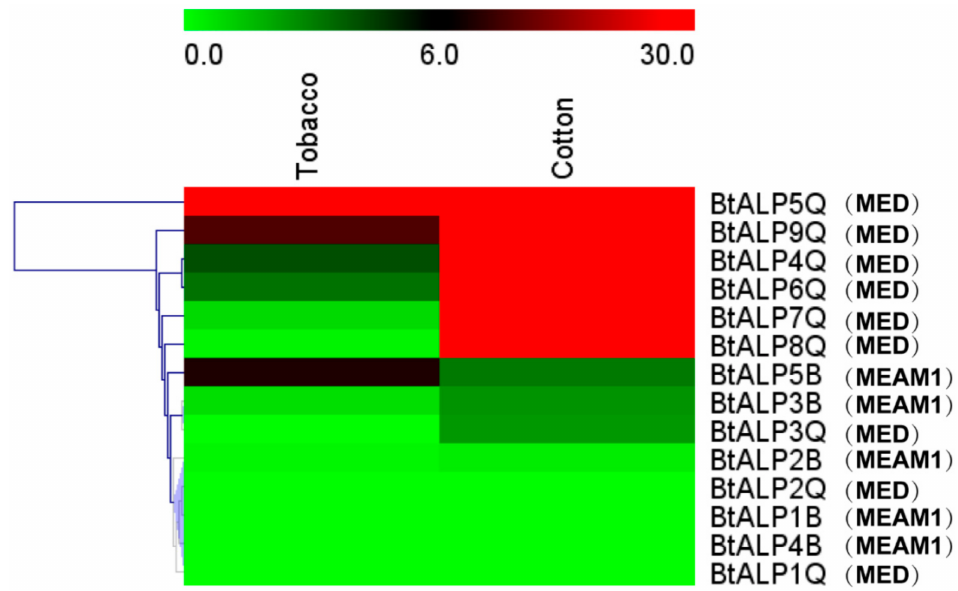
Figure 3. Analysis of expression profiles of ALP genes from B. tabaci MEAM1 and MED. Heat map showing the real-time quantitative PCR analysis results of BtALP genes in two plants. The bar colors vary from green (low) to red (high), representing the scale of relative expression levels. Each row represents a B. tabaci MEAM1 and MED